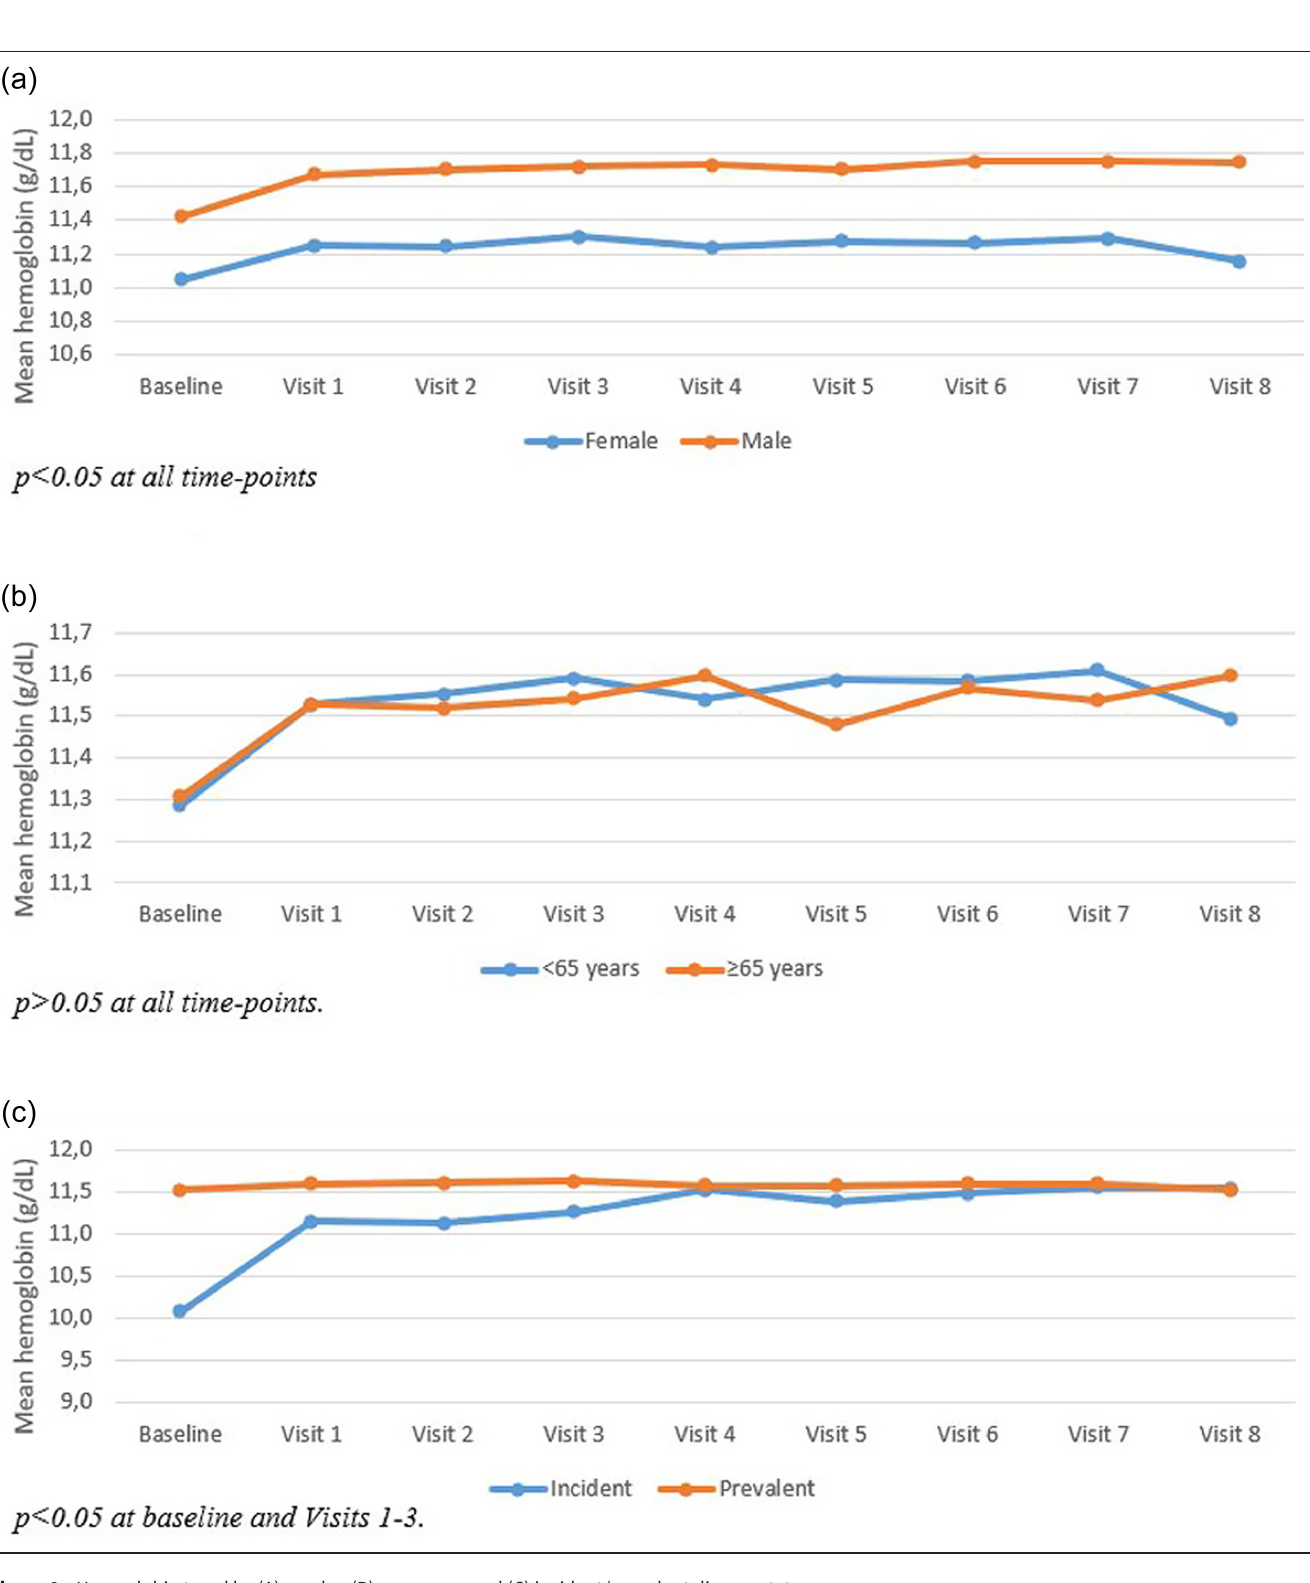
Figure 2. Hemoglobin trend by (A) gender, (B) age group, and (C) incident/prevalent disease